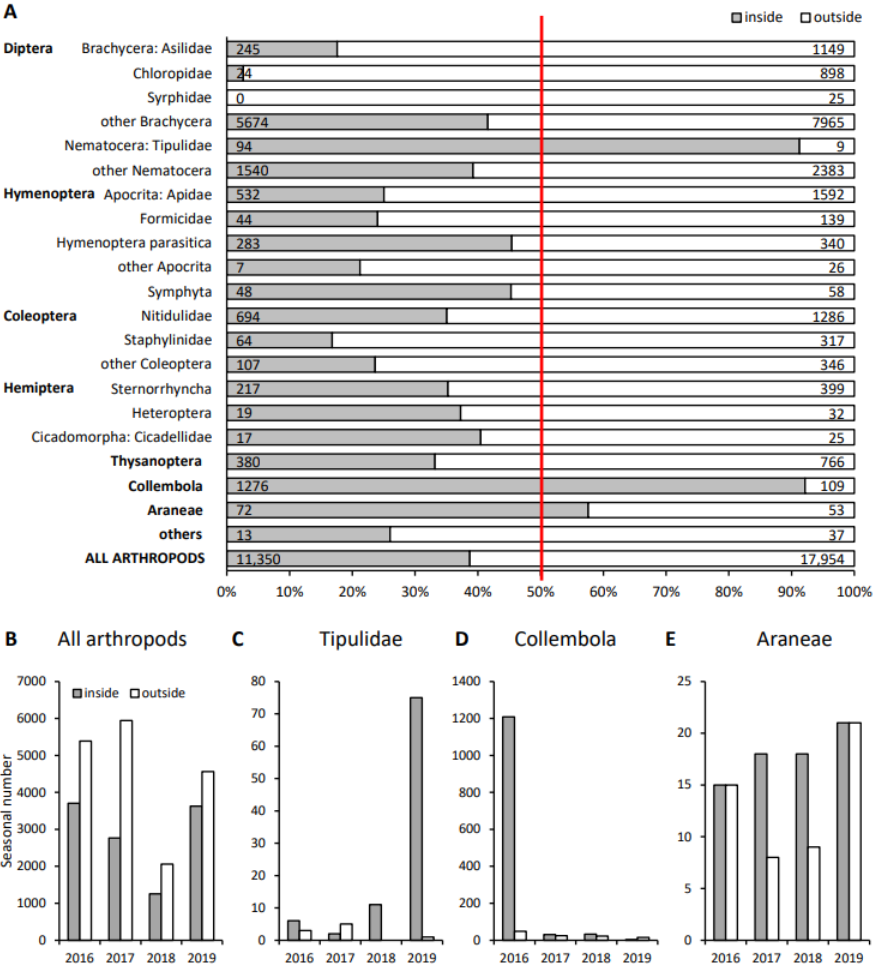
Figure 1. Arthropods collected in coloured pan traps placed inside and outside the netted plot of apple trees during the flowering period in the years 2016–2019. ( A ) Relative abundance of different arthropod taxa. The red line indicates equal numbers inside and outside. Absolute numbers are displayed in the bars. The lower panels represent yearly numbers of ( B ) all arthropods, ( C ) crane flies (Tipulidae), ( D ) springtails (Collembola), and ( E ) spiders (Araneae). Most of the collected arthropods (20,006) belong to the order of Diptera, with the majority being undetermined flies (Brachycera) and midges (Nematocera) (Figure 1A, Table S2).